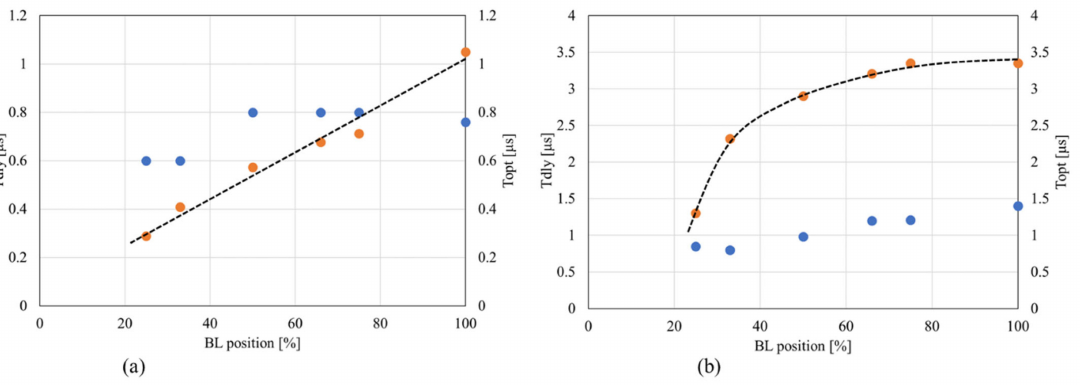
Figure 12. Address-dependent optimum PE time (Topt) in blue and the delay time with Topt in orange for the BL voltage ( a ) and the sensed current ( b ) with three-line